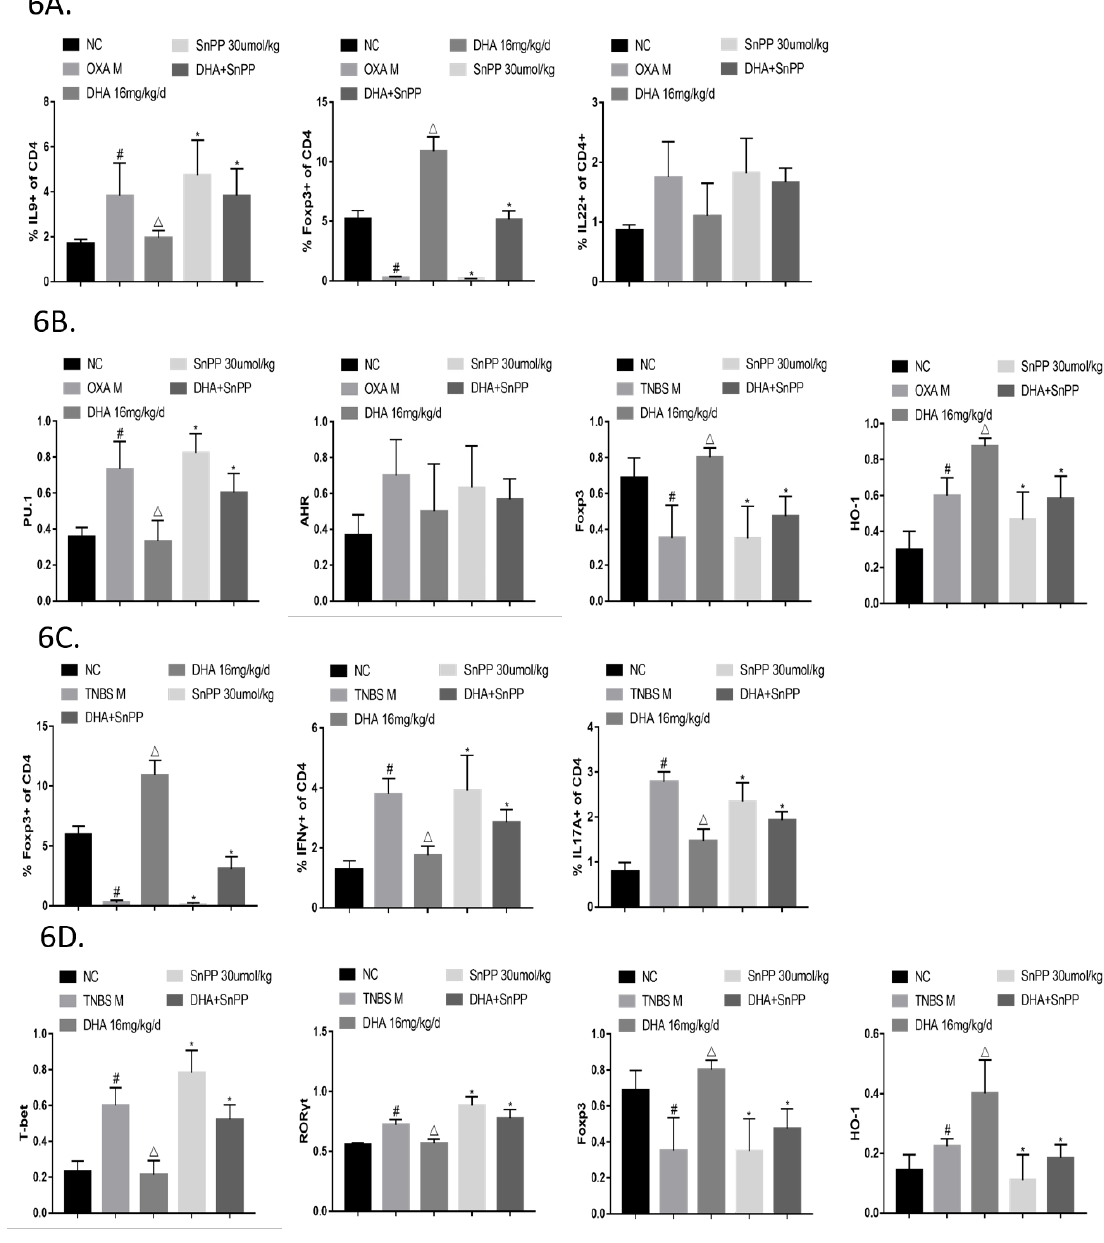
Figure 6. Dihydroartemisinin (DHA) regulates the Th / Treg balance in oxazolone (OXA)- and 2,4,6-trinitro-benzene sulfonic acid (TNBS)-induced colitis via HO-1. ( 6A ) Lymphocytes were isolated from mouse spleens. CD4 + IL9 + , CD4 + IL22 + and CD4 + CD25 + Foxp3 + cells were determined by flow cytometry. ( n = 5). ( 6B ) Lamina propria mononuclear cells (LPMCs) were isolated and subjected to RIPA lysis for protein collection. The protein amounts of PU.1, AHR, Foxp3, and HO-1 were estimated by capillary electrophoresis immunoblotting. ( n = 3). ( 6C ) Lymphocytes were isolated from mouse spleens. CD4 + IFN γ + , CD4 + IL17A + and CD4 + CD25 + Foxp3 + cells were determined by flow cytometry. ( n = 5). ( 6D ) Lamina propria mononuclear cells (LPMCs) were isolated and subjected to RIPA lysis for protein collection. The protein amounts of T-bet, Foxp3, and HO-1 were estimated by capillary electrophoresis immunoblotting. ( n = 3). (Compared to the NC group, # p < 0.05, compared to the model group, △ p <0.05, compared to the DHA group, * p <0.05).